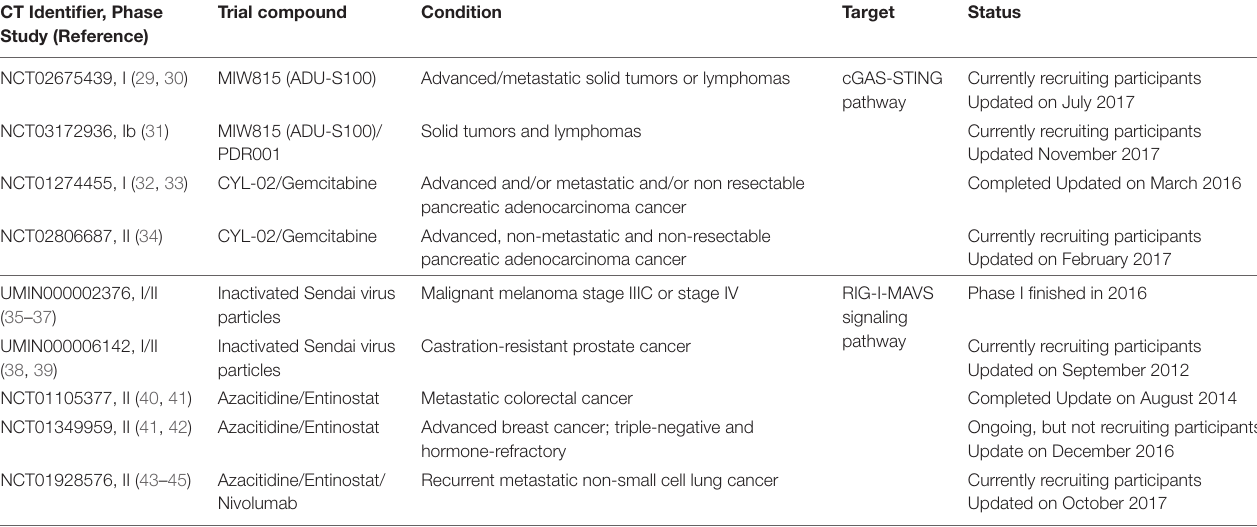
TAbLe 1 | Cytosolic DNA sensors targeting clinical trials. CT identifier, Phase Study